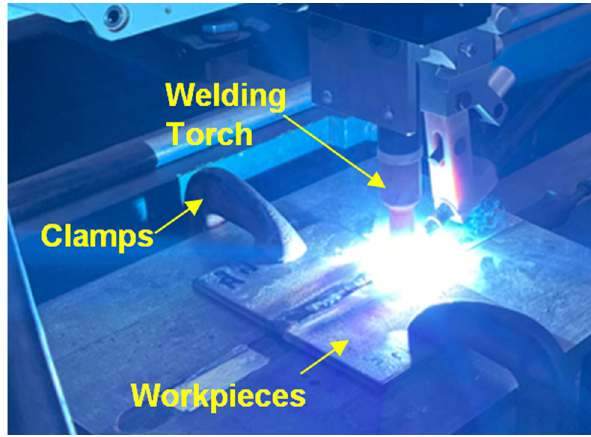
Table 2: Chemical composition of base materials and fi ller wire ( wt% )